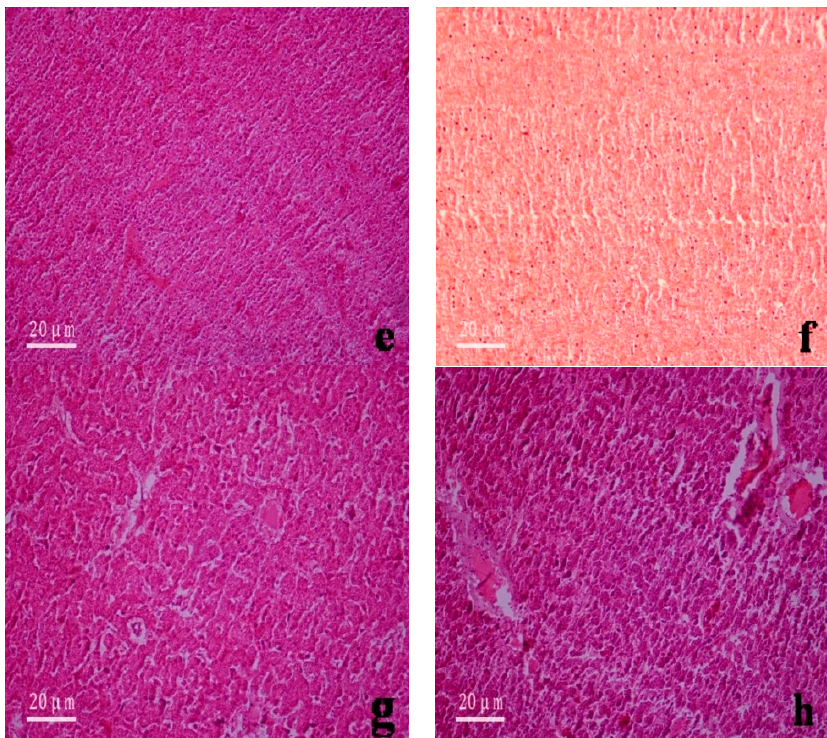
Figure 4. Microstructure of the gill and liver tissues of Anguilla japonica under the microscope (×200). ( a ) Normal gill tissues (seawater); ( b ) Normal gill tissues (freshwater); ( c ) Gill lamellae after divalent mercury ion treatment (seawater); ( d ) Gill lamellae after divalent mercury ion treatment (freshwater); ( e ) Normal liver tissues (seawater); ( f ) Normal liver tissues (freshwater); ( g ): Inflation between hepatocytes after divalent mercury ion treatment (seawater); ( h ): Appearance of blood spots among liver tissues after divalent mercury ion treatment (freshwater).